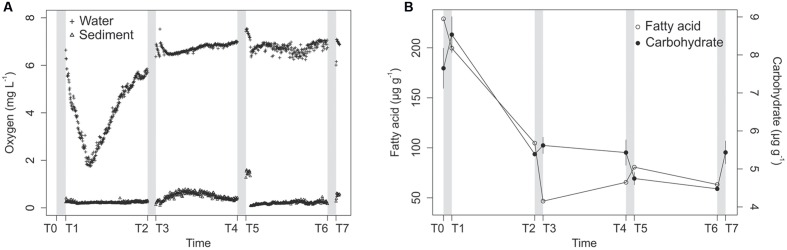
Oxygen concentrations in the water (crosses) and sediments (triangles) along the course of the experiment
(A), and Lemna sp. fatty acids (open circles) and total carbohydrate concentrations (filled circles) in the experimental sediments (B). Lemna sp. fatty acids are represented by the sum of four characteristic saturated, monounsaturated, and polyunsaturated fatty acids (see “Material and Methods”). Gray bars represent the disturbance events.